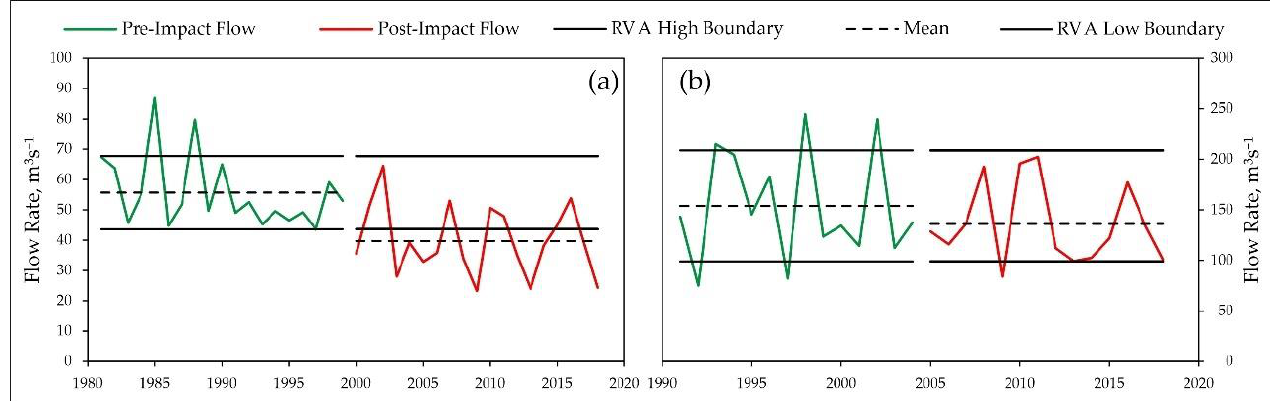
Figure 13. Hydrologic alteration (in m 3 s − 1 ) of extreme flow conditions (7-day maximum) in the Bartuva downstream of Skuodas HPP ( a ); in the J¯ura downstream of Taurag˙e HPP ( b